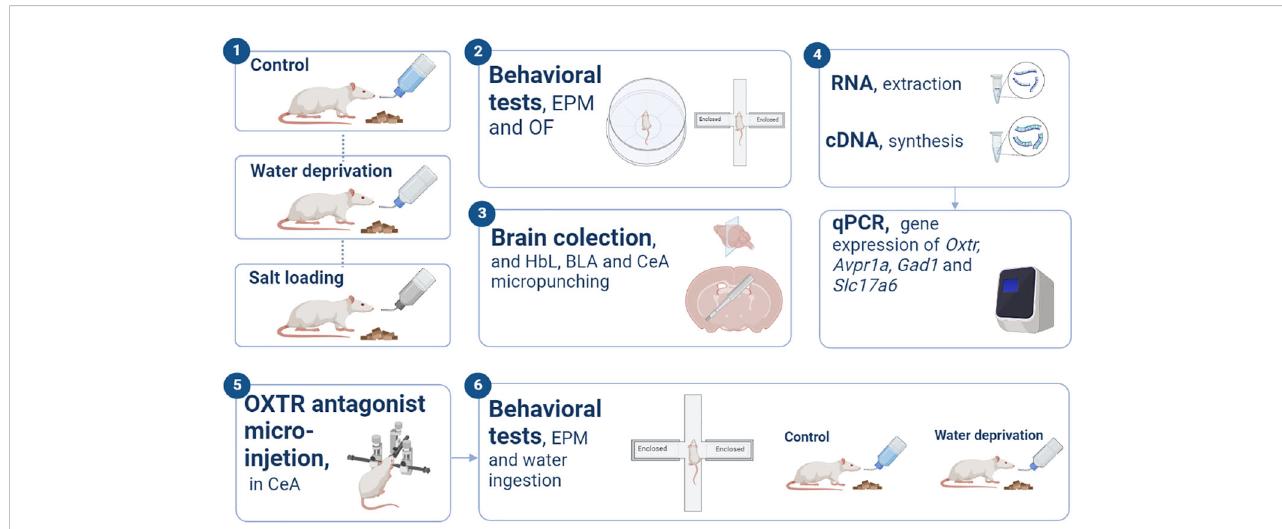
FIGURE 1 Experimental procedures. Schematic illustration representing the experimental designs and basic procedures employed in the present study. “ EPM ” , elevated plus maze; “ OF ” , open fi eld; “ LHb ” , Lateral habenula; “ BLA ” , basolateral amygdala; “ CeA ” , Central amygdala; “ OXTR ” , oxytocin